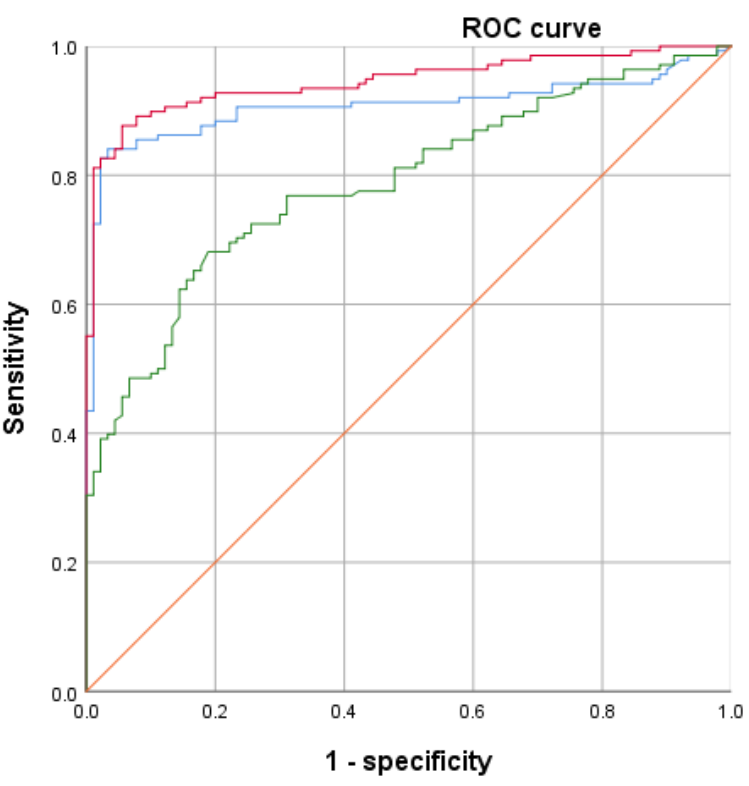
Figure 4. ROC curves of CA19-9, PIVKA-II, and their combination for distinguishing pancreatic ductal adenocarcinoma. ROC, Receiver operating characteristics; PIVKA-II, protein induced by vitamin K absence-II; CA19-9, carbohydrate antigen